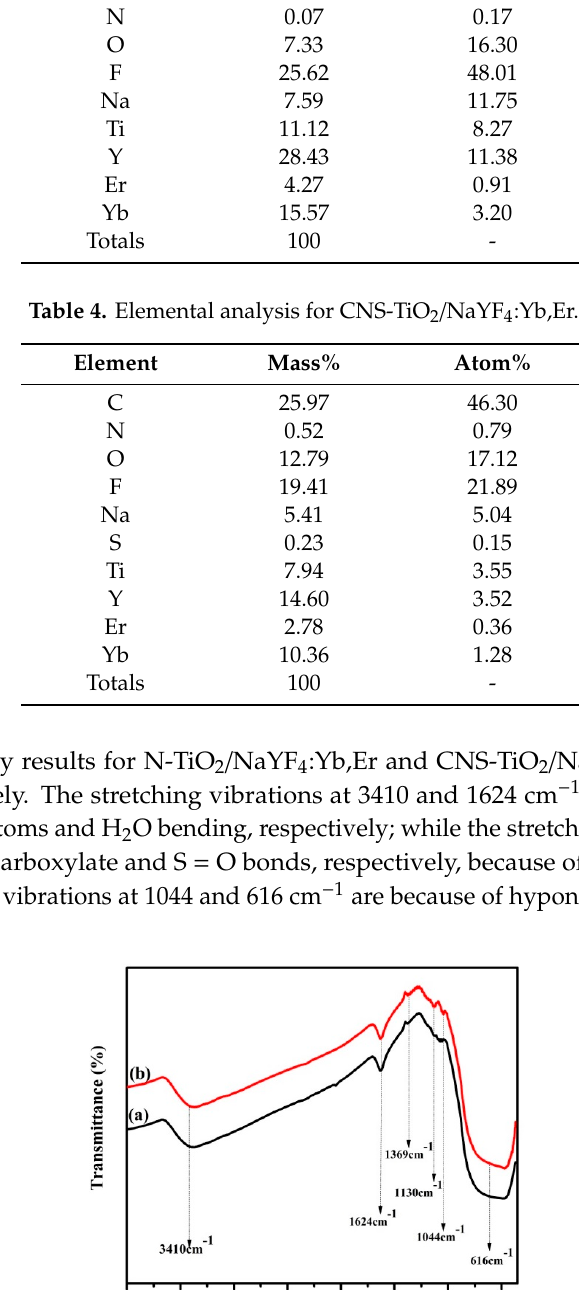
Table 3. Elemental analysis for N-TiO 2 /NaYF 4 :Yb,Er.